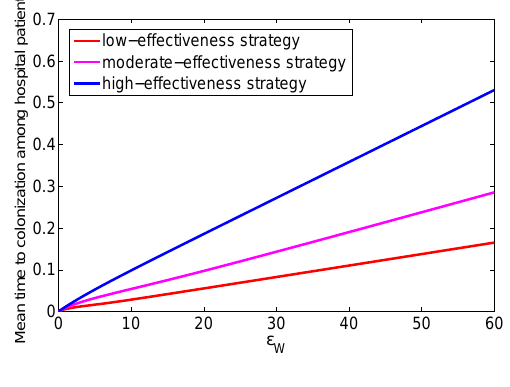
Fig. 5. Simulations of the model (2.1), showing the Mean time to colonization among hospital patients un- der various effectiveness levels of the control strategies. Other parameter values used are as given in Table